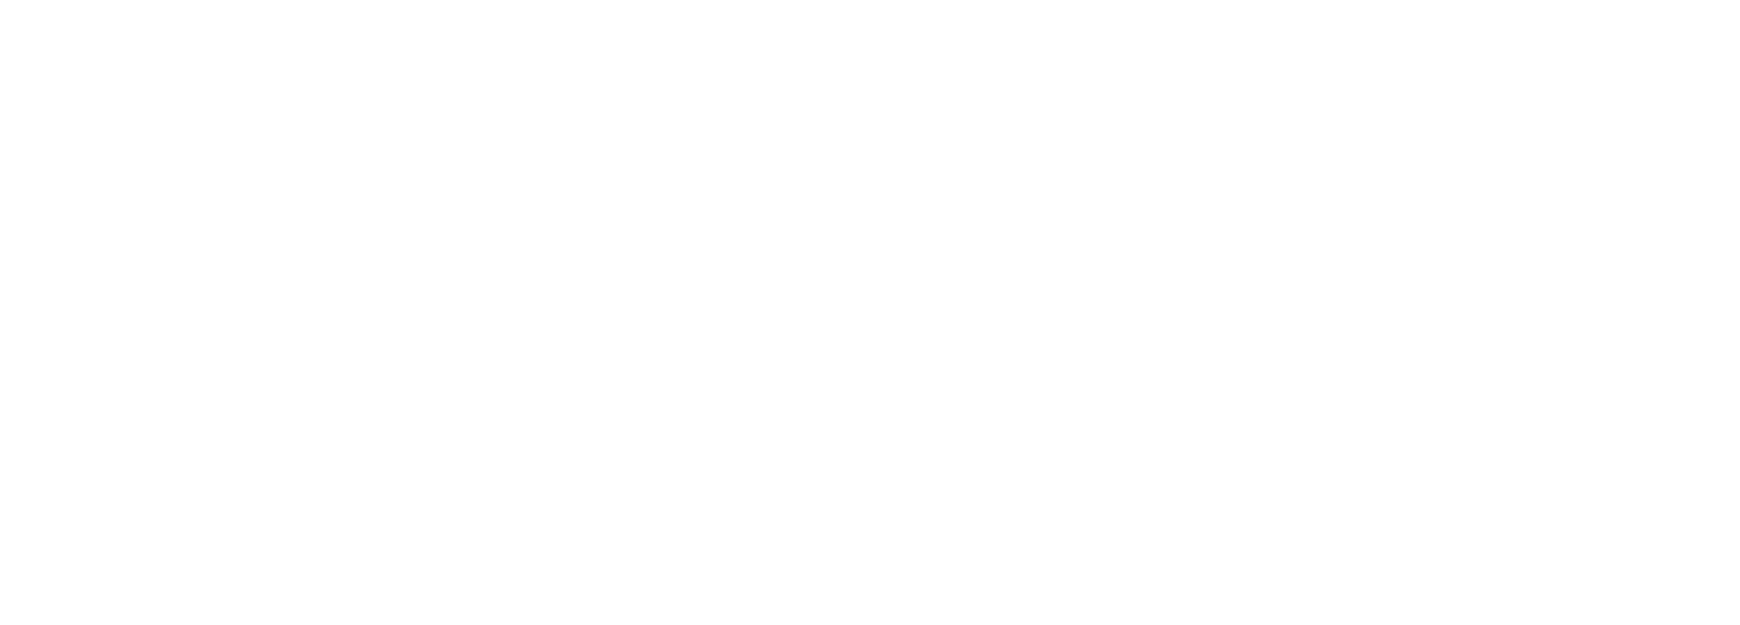
Table 2. Calculated interaction energies ( ∆ E , kCal mol − 1 ) for nitrogen-doped porous carbon (NC) and pristine carbon with phosphorus adsorbed on different sites. Position O N Functional Pyridinic Pyrrolic Nitrogen Pyridinic Pyrrolic Nitrogen Pyridinic Pyrrolic group N_COOH N_COOH free_COOH N_C=O N_C=O free_C=O N_COOH N_COOH N_C=O N_C=O Interaction − energies